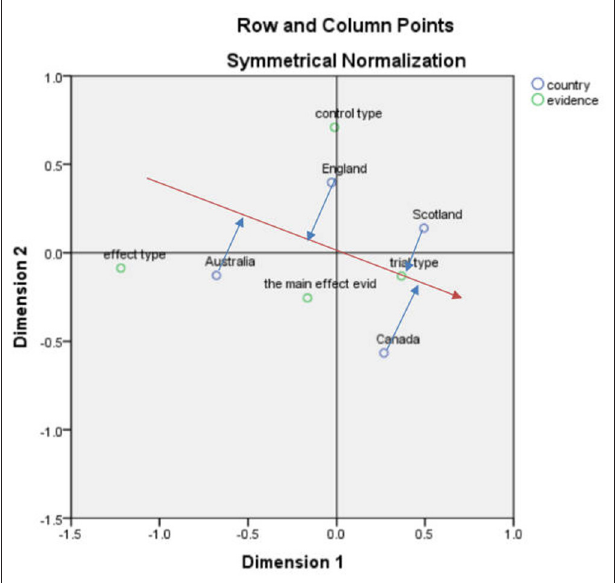
FIGURE 1 | Correspondence analysis biplot (country and clinical evidence).